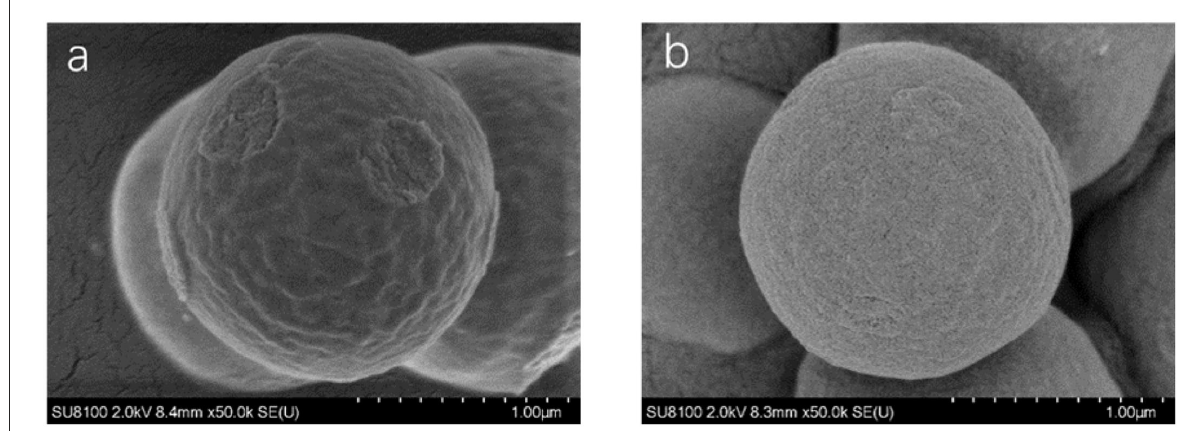
FIGURE4 Scanning electron micrographs of MIP (a) and NIP (b) .